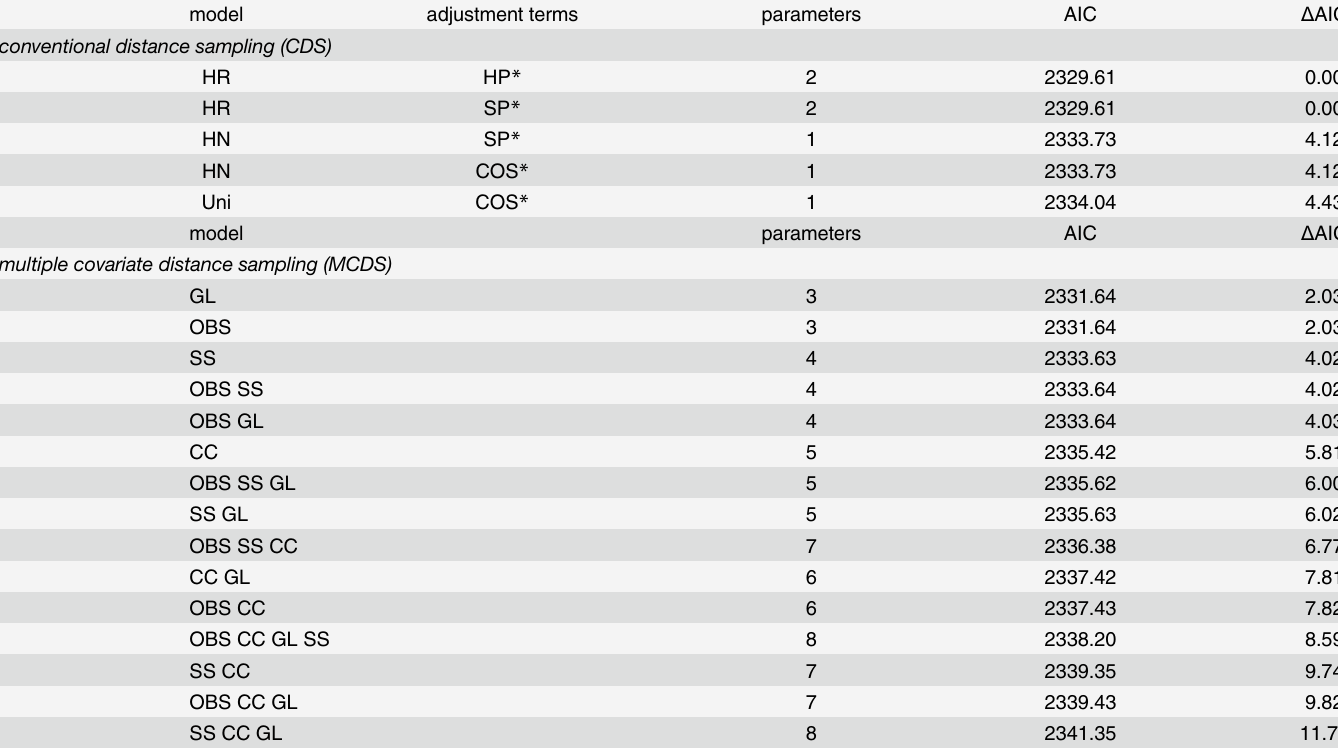
Table 2. Akaike ’ s Information Criterion (AIC) values for the conventional distance sampling and multiple covariate distance sampling models of the detection function tested.